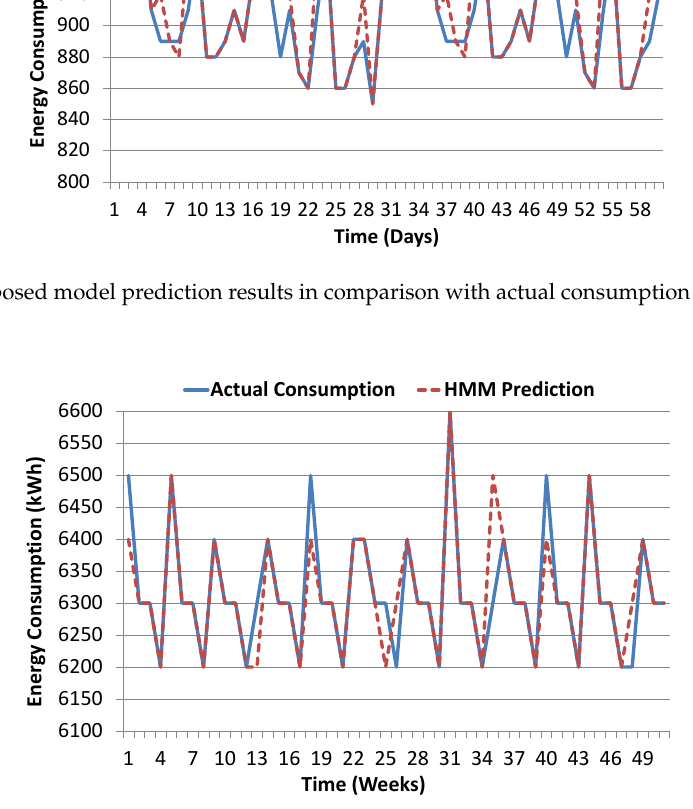
Figure 16. Proposed model prediction results in comparison with actual consumption for one year weekly